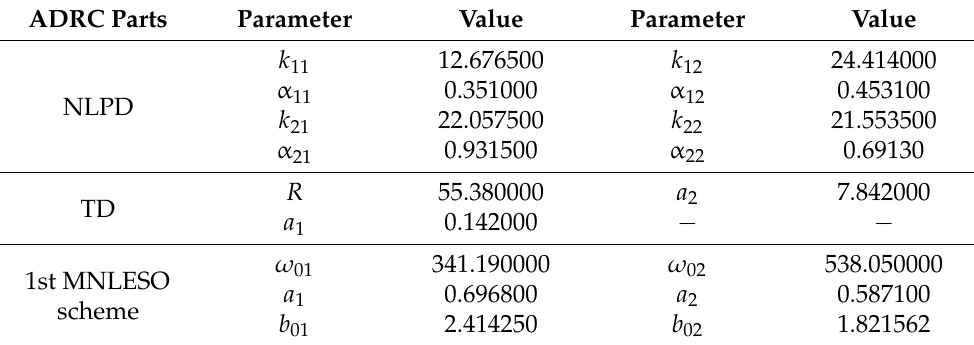
Table 9. NLPD-ADRC parameters (1st MADRC scheme).